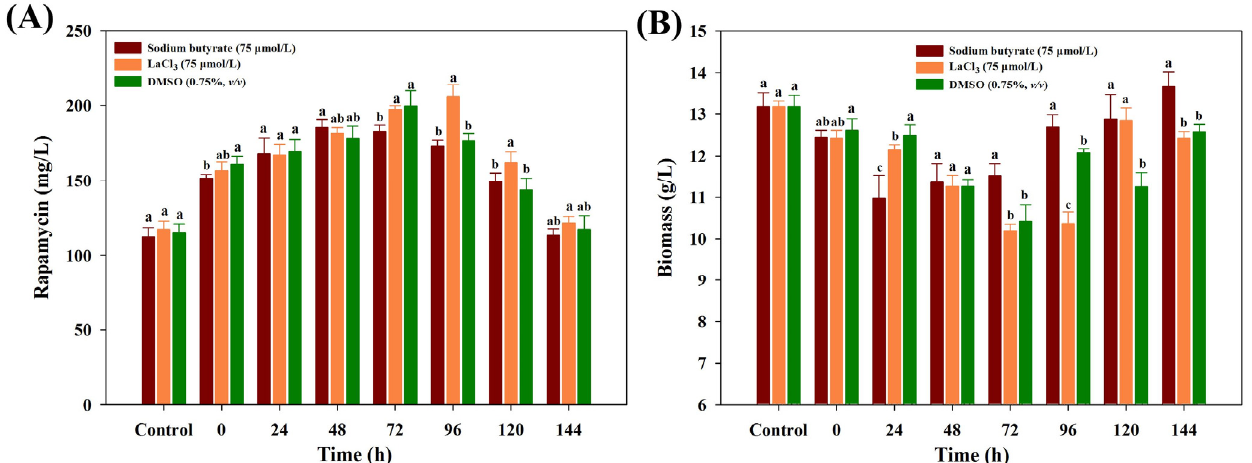
Figure 2. Effects of different feeding time points on the final rapamycin production ( A ) and biomass contents ( B ) under the three kinds of chemical elicitor treatments. Three biological replicates were used to perform multivariate analysis of each treatment. The significant differences ( p < 0.05) of rapamycin yields were marked with the lowercase letters among the different strains.